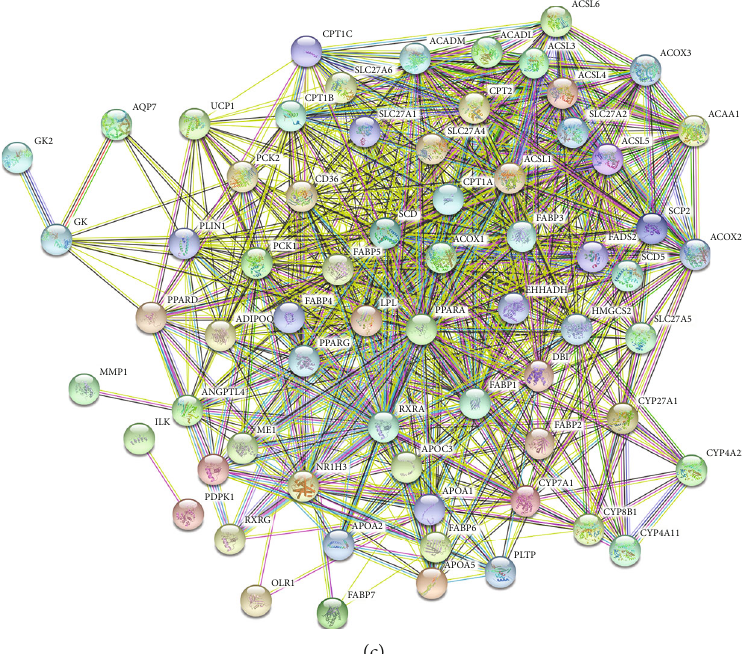
Figure 2: The expression of genes related to the PPAR signaling pathway in BRCA and univariate Cox regression analysis. (a) The heat map shows the expression of genes related to the PPAR signaling pathway in BRCA. ∗ P < 0 : 05 , ∗∗ P < 0 : 01 , and ∗∗∗ P < 0 : 001 . (b) The forest plot shows the results of univariate Cox analysis of PPAR signaling pathway-related genes in BRCA. (c) PPAR signaling pathway-related molecular interaction network